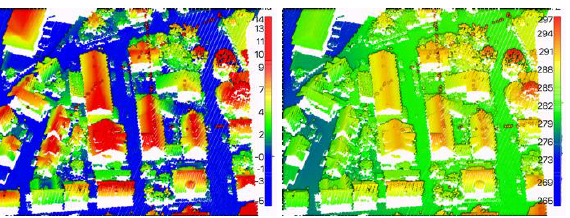
Figure 13. Height above ground feature (left) and elevation values (z-coordinates) of points coloured for evaluation data (right). Unit of the legend is meters.